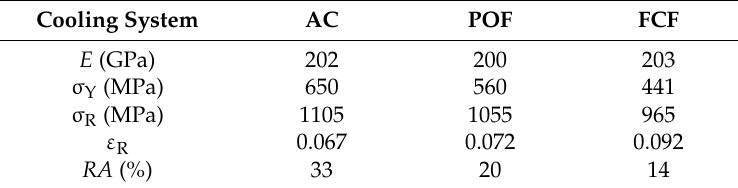
Table 2. Mechanical properties obtained by standard tensile tests.